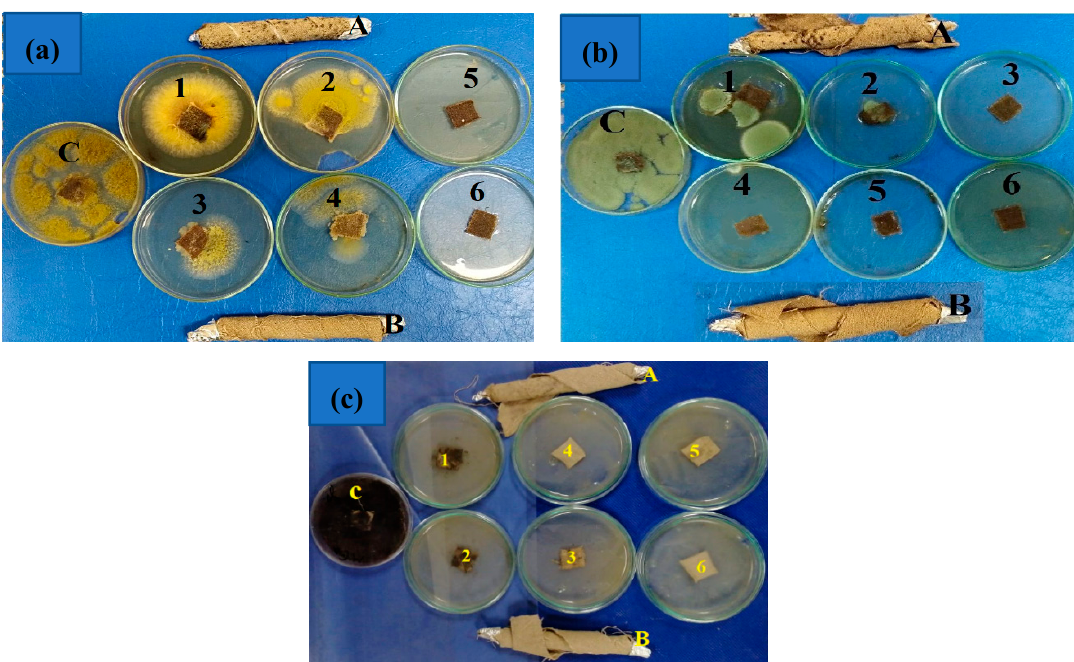
Figure 4. Photo of the antifungal activity of linen fumigated with different concentrations of V. agnus-